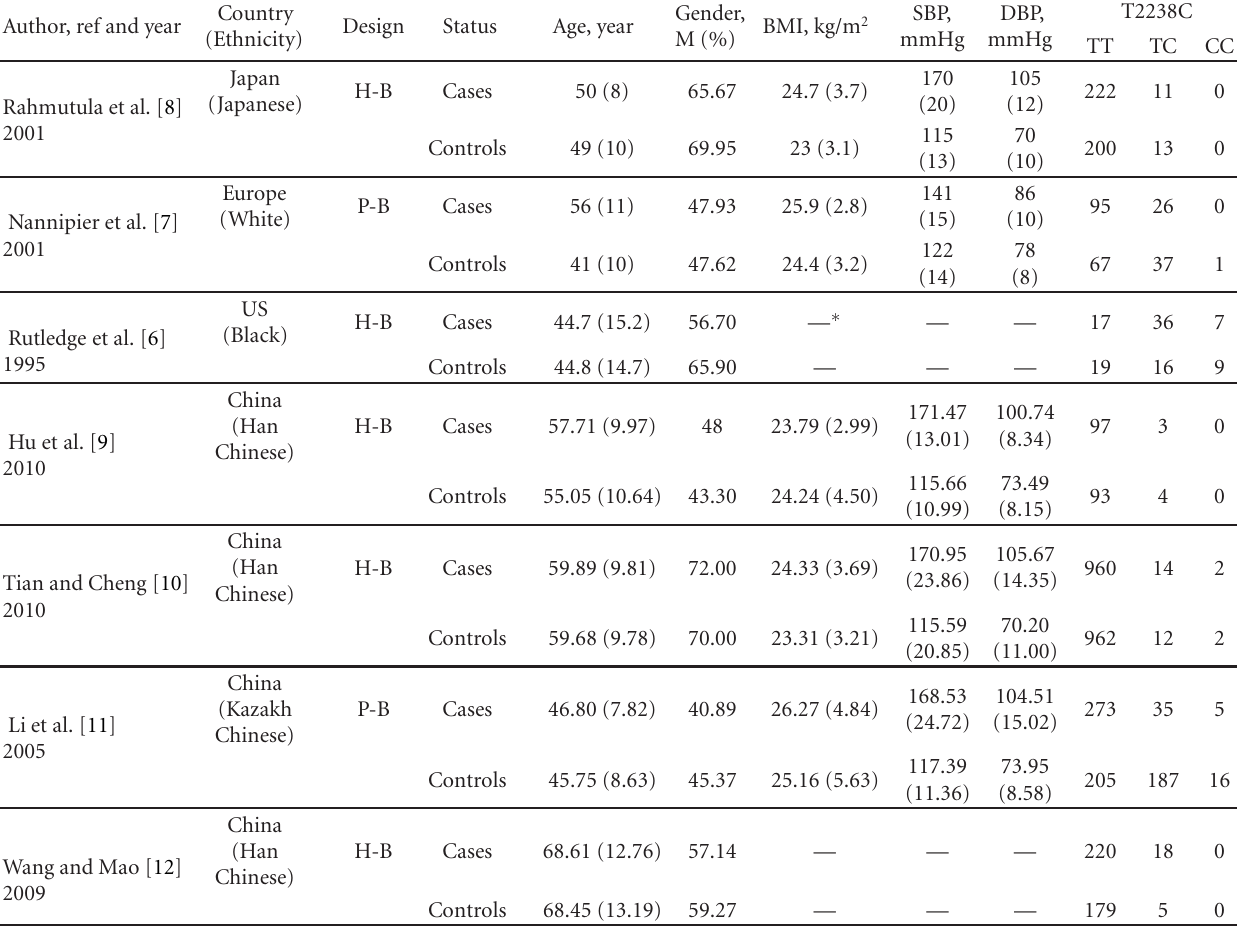
Table 1: The baseline characteristics of all qualified studies in this